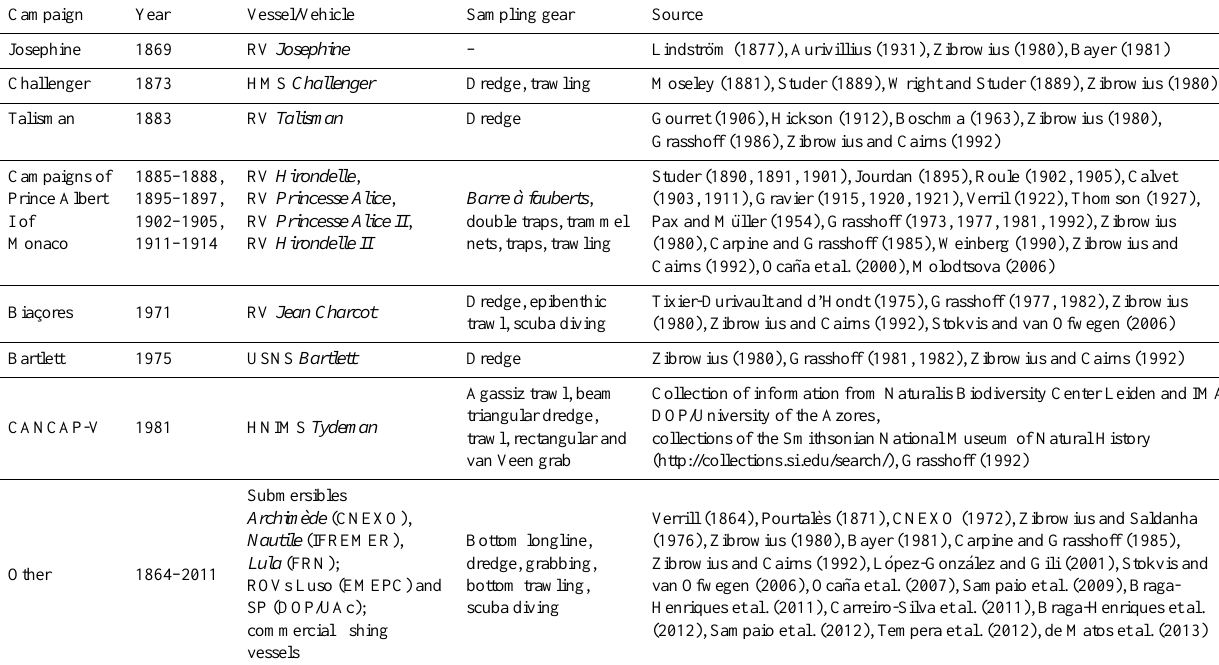
Table 1. Data sources for the coral records obtained during the major oceanographic expeditions between 1869–1981 and other events with sporadic records. References herein were also used in the nomenclature